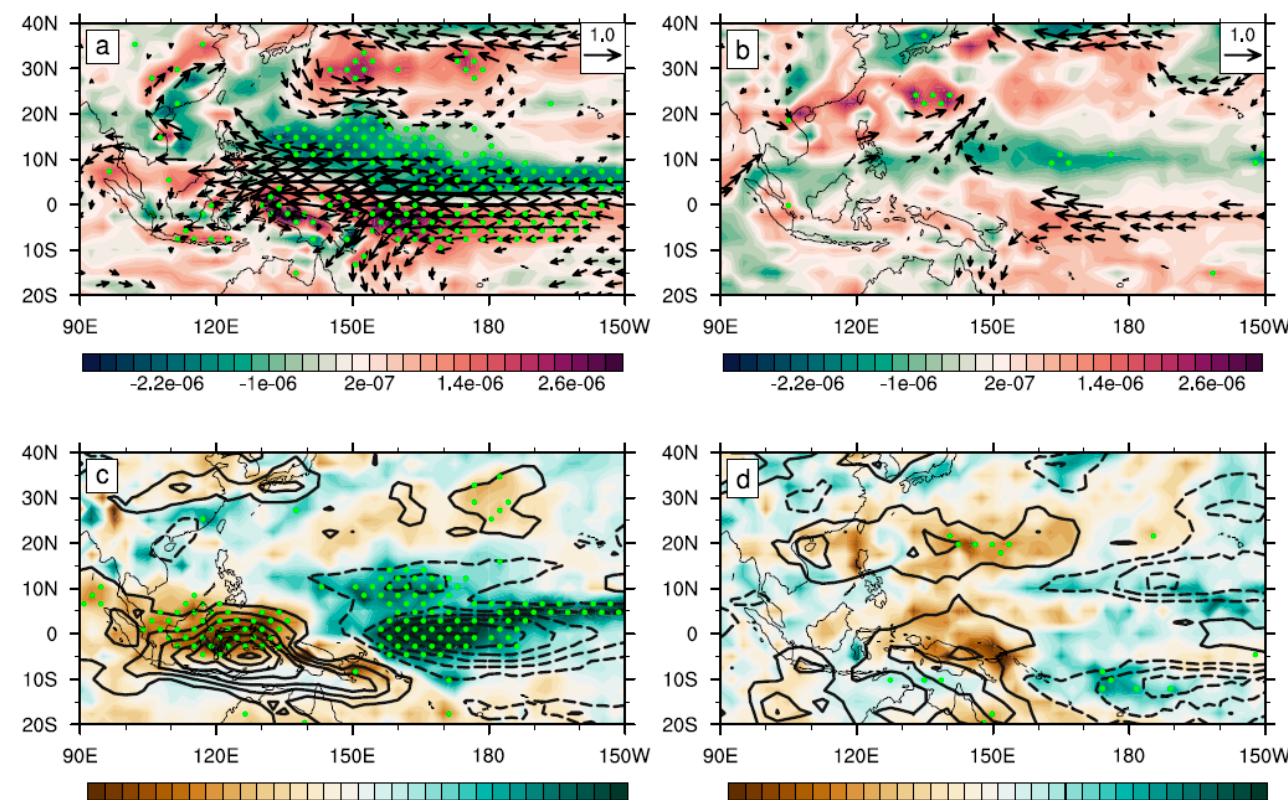
Figure 4. Regression of ( a , b ) 850 hPa winds (vectors, exceeding the 95% significance level based on the two-sided Student’s t -test, unit: m/s) and relative vorticity (shading; s − 1 ) anomalies, ( c , d ) 500 hPa vertical velocity (shading, Pa/s) and 700 hPa specific humidity (contours, interval of 0.1 g/kg; zero contours are omitted) anomalies in JJA onto the normalized JFM SH index during ( a , c ) 1980–2002 and ( b , d ) 2003–2020. The green dots in ( a – d ) denote the significant relative vorticity and vertical velocity anomalies above the 95% confidence level based on the two-sided Student’s t -test, respectively. In addition, WNP heating as represented by the precipitation rate features a significant cooling anomaly during P1. Weakened vertical wind shear between the upper and lower layers significantly occurs over the tropical western Pacific, but its anomalies show relatively strong but insignificant vertical wind shear over the subtropical western Pacific. During P2, WNP heating still has no significant response, although vertical wind shear anomalies show significantly positive over the subtropical central-western